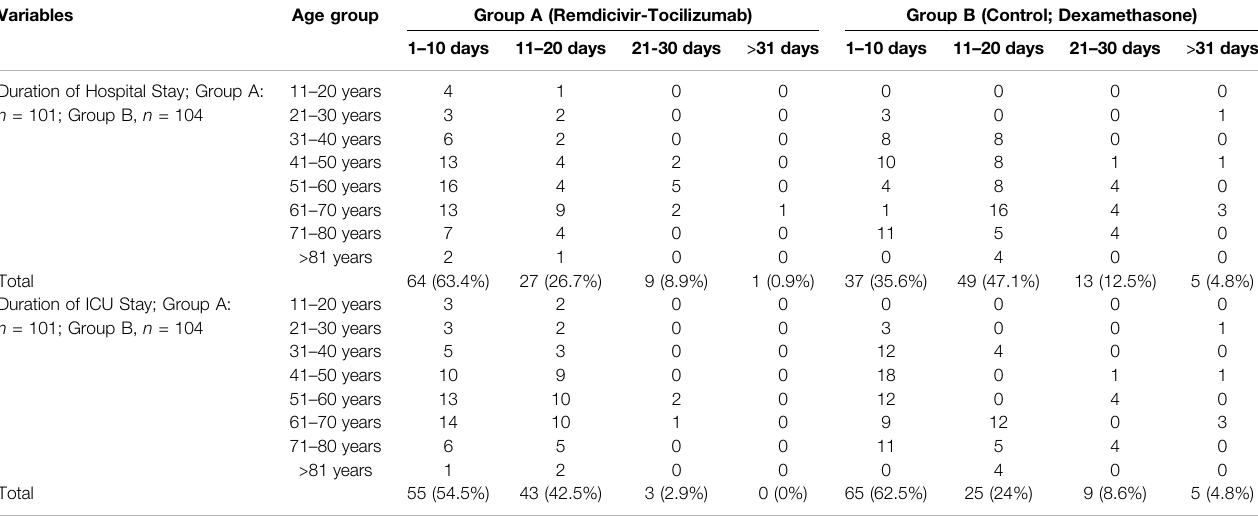
TABLE 3 | Subgroup analysis of the total duration of hospitalization and ICU stay against the age group. Variables Age group Group A (Remdicivir-Tocilizumab) Group B (Control; Dexamethasone)